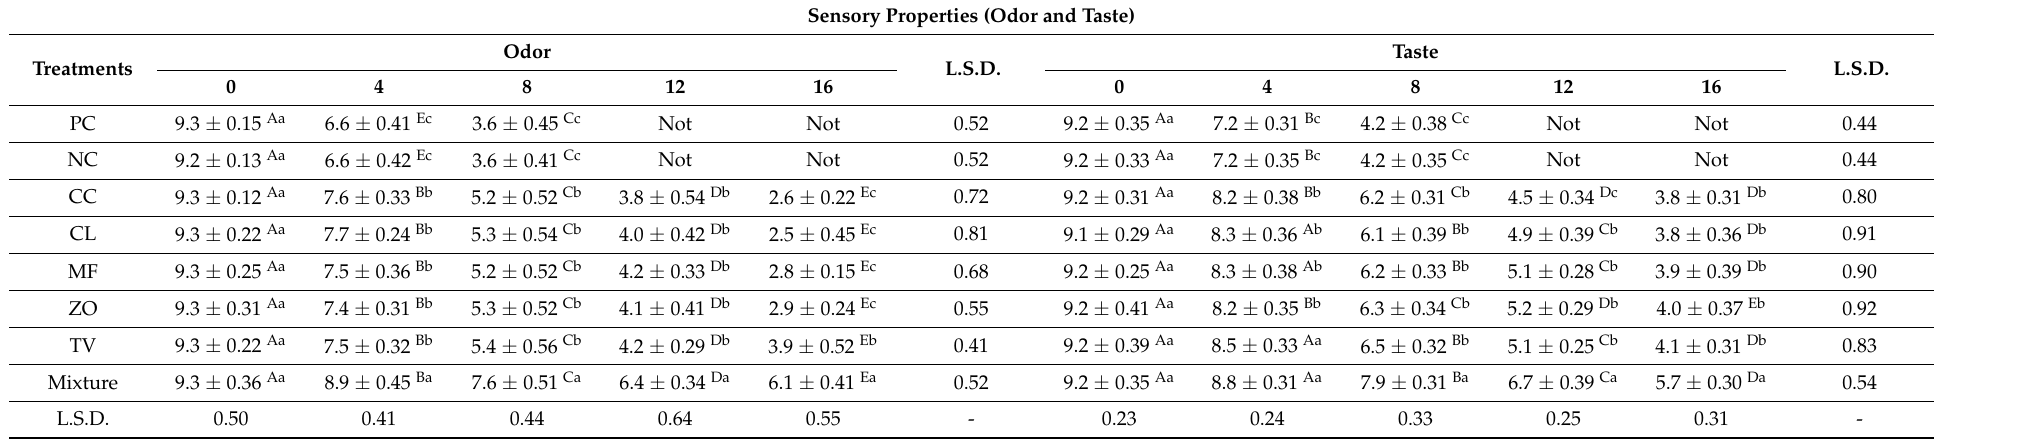
Table 7. Sensory evaluation of cold stored rabbit meat formulated with some plant aqueous